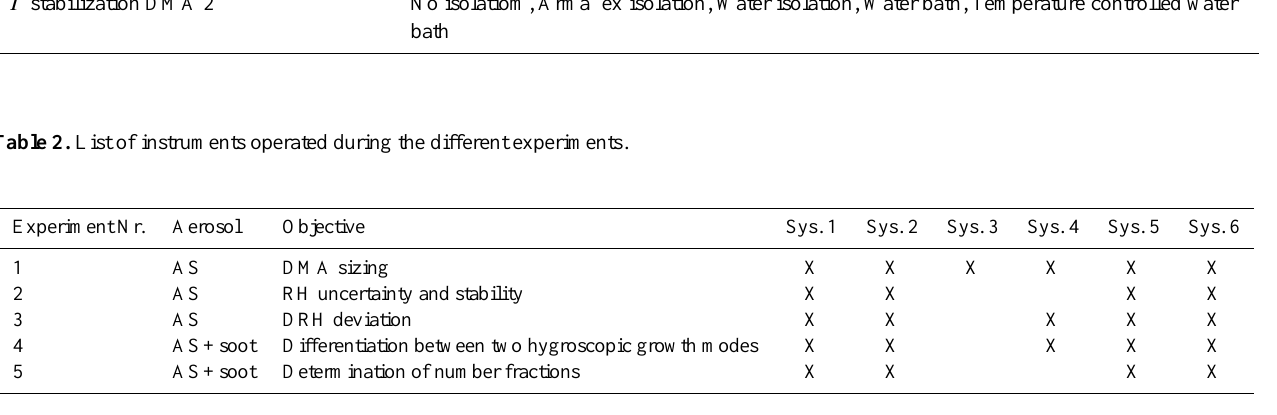
Table 2. List of instruments operated during the different experiments.